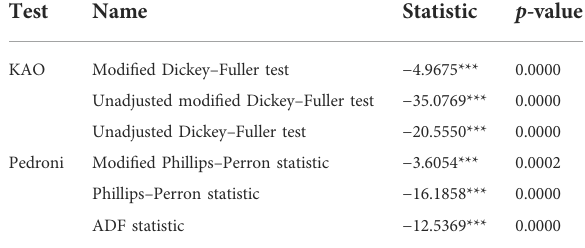
TABLE 4 Cointegration test results.